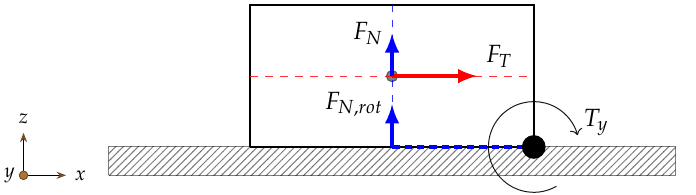
Figure 3. Sketch of single PM layer fragment and considered hydrodynamic forces. Tangential contributions red, normal contributions blue. Torque around y -axis at eccentric contact